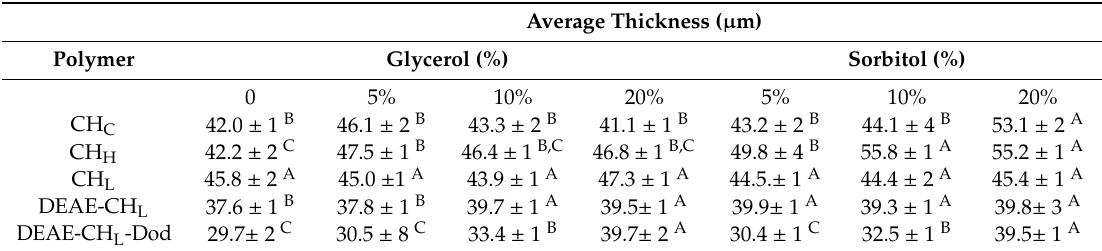
Table 3. Average thickness of chitosan films prepared with increasing percentages of glycerol and sorbitol at a relative humidity of 53%.